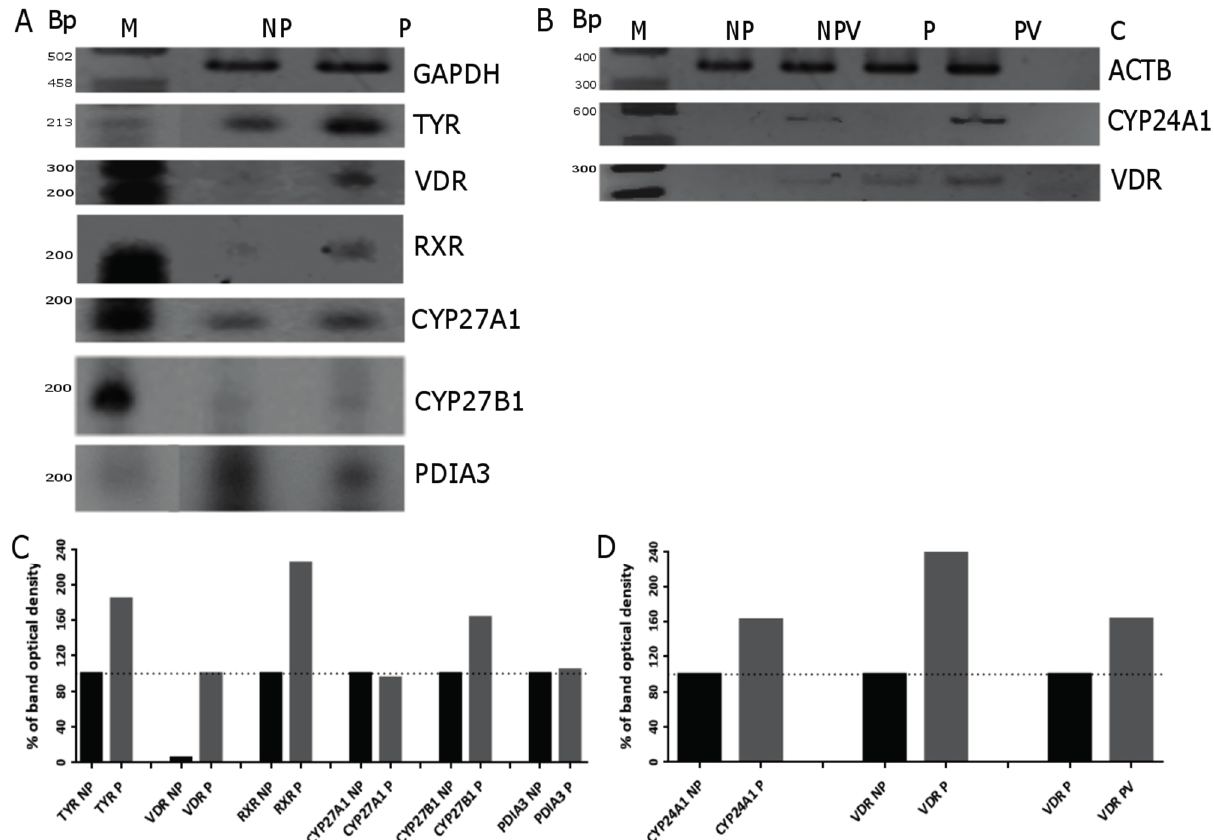
Figure 5. Melanogenesis and 1,25(OH) 2 D 3 modulate the expression of tyrosinase ( TYR ), Vitamin D receptor ( VDR ), retinoid X receptor ( RXR ), disulfide isomerase ( PDIA3 ), 25-hydoxylase ( CYP27A1 ) and 1 α -hydroxylase ( CYP27B1 ) genes in hamster Ab melanoma cells. The effects of pigmentation ( A ) and 1,25(OH) 2 D 3 on pigmented and non-pigmented cells ( B ) on the expression of selected genes were measured by semi-quantitative PCR. PCR analysis was performed as described in Materials and Methods. Glyceraldehyde 3-phosphate dehydrogenase (GAPDH) and β -actin (ACTB) were used as control genes. Length of amplicon fragments (in base pairs): GAPDH (496), Actin (353), TYR (205), VDR (234), RXR (210), CYP27A1(209), CYP27B1 (189), CYP24A1 (201). Densitometric analysis of PCR results (from panel A and B) obtained using TotalLab Quant v 11.4 ( C , D ). M, DNA marker; NP, non-pigmented cells (F10); NPV, non-pigmented cells treated with 1,25(OH) 2 D 3 ; P, pigmented cells (DMEM); PV, pigmented cells treated with 1,25(OH) 2 D 3 ; and C, control. Panels C and D showed quantification of band density from panels A and B ,